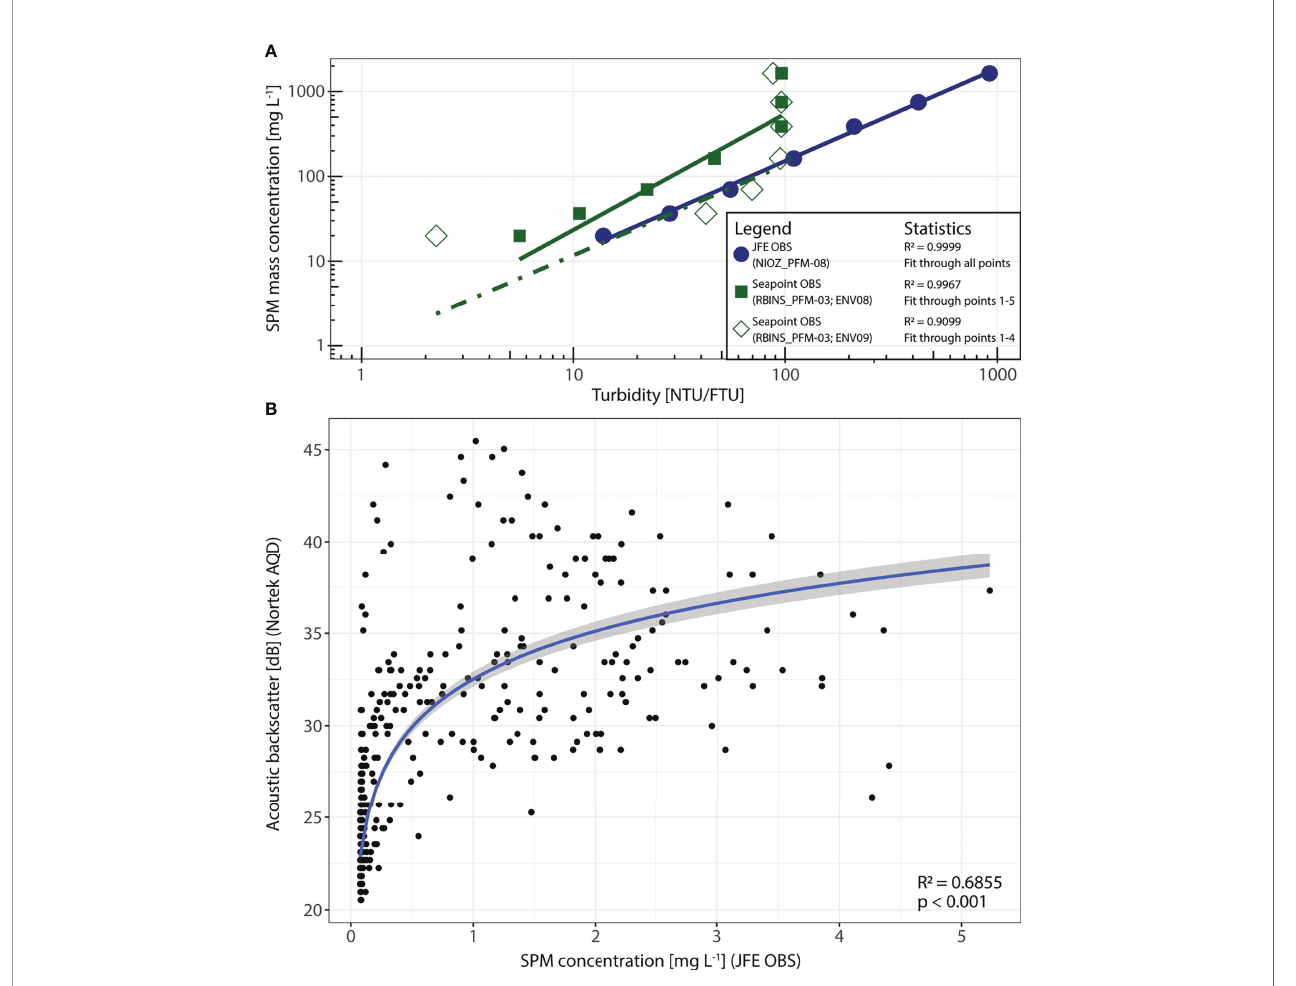
FIGURE 4 | (A) Correlation between recorded turbidity of several optical backscatter sensors (OBSs) as measured during onboard calibration and SPM mass concentration. Results are shown for the JFE Advantech OBS NIOZ_ENV14 as used on platform NIOZ_PFM-08 (blue) and the Seapoint OBS RBINS_ENV08 (SP1; green solid squares) and Seapoint OBS RBINS_ENV09 (SP2; green open squares), used on sensor platform RBINS_PFM-03. The linear regressions are used for the conversion of the recorded turbidity signal into SPM mass concentration. Note that for the Seapoint OBSs the regression line is only fi tted to the fi rst 4 or 5 points, as the other higher calibration steps were beyond the saturation level of these OBSs, resulting in a constant response (saturation) of these sensors above 100 NTU. (B) Correlation between SPM mass concentration as recorded at sensor platform NIOZ_PFM-08 (200 m south of the dredge tracks) by a JFE Advantech OBS (x- axis) and converted acoustic backscatter in dB as recorded by the Nortek Aquadopp pro fi ler (y-axis) at the same site on the 11 th